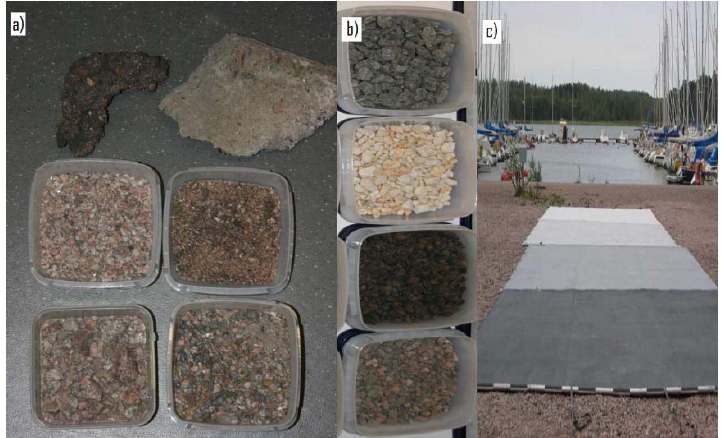
Figure 2. (a) Natural samples collected in Espoonlahti Harbor, from top left: asphalt, concrete, football field gravel, beach sand, harbor gravel and walkway gravel. (b) Commercial gravel that was used during the December 2006 flight. From top to bottom: Diabase, Quartz, LECA and Gravel. (c) Brightness tarps on the ground during the August 2006 flight: 10%, 30%, 50% and 70% nominal